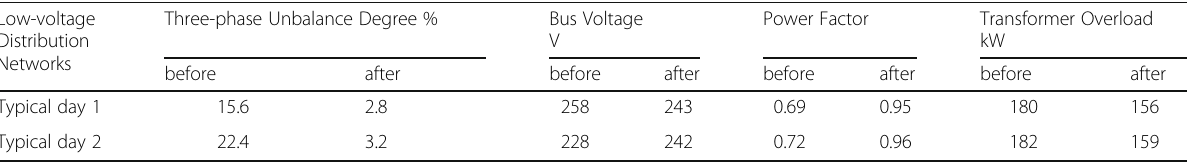
Table 1 Comparison of experimental data before and after power quality enhancement Low-voltage